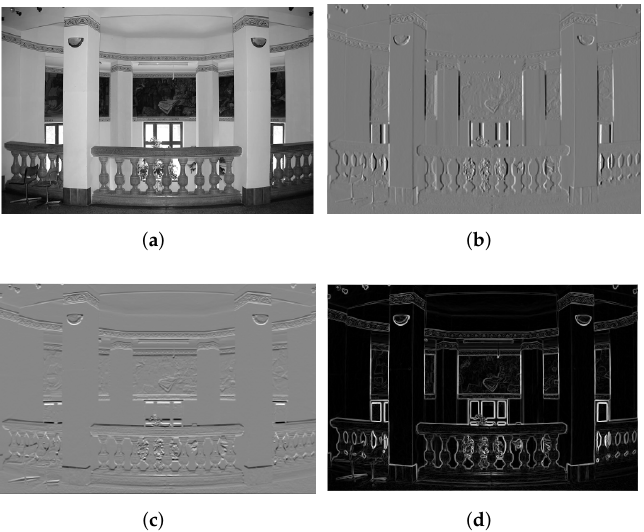
Figure 4. Illustration of Scharr operator: ( a ) Grayscale test image, ( b ) Normalized x -gradient from Scharr operator, ( c ) Normalized y -gradient from Scharr operator, ( d ) Normalized gradient magnitude from Scharr